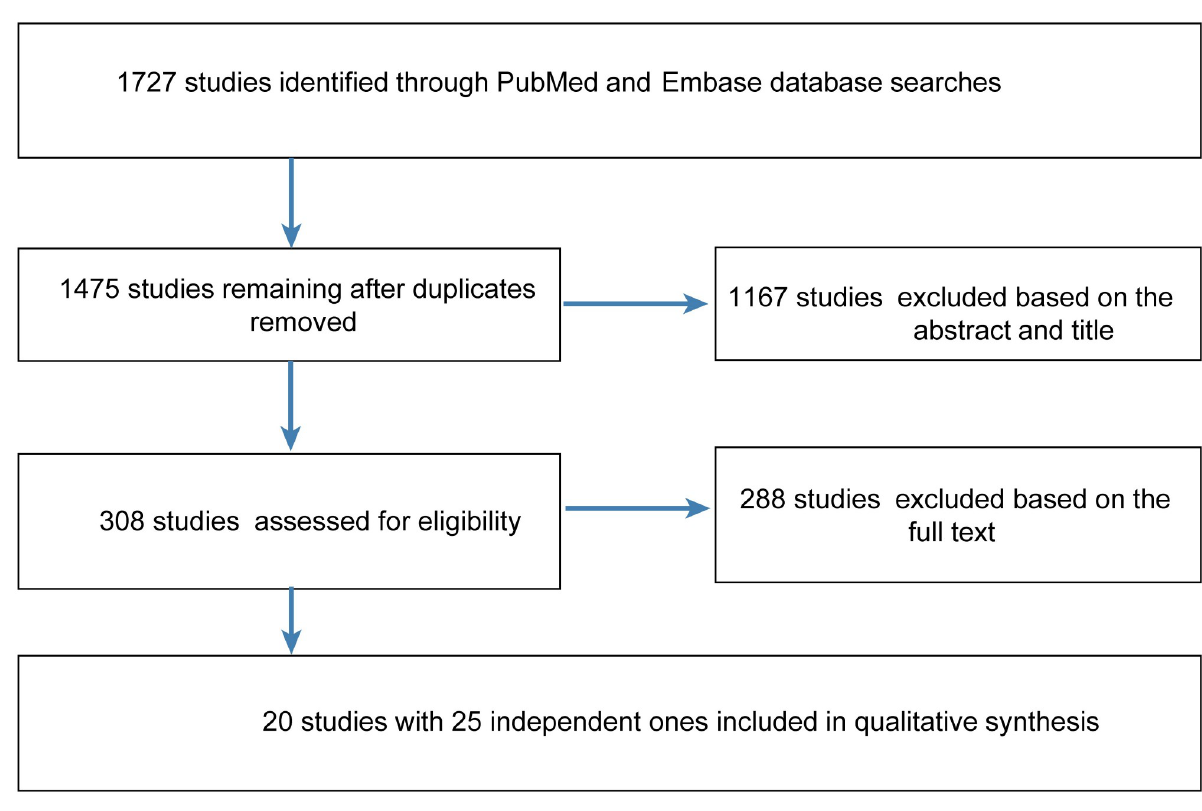
Fig 1. Flow diagram of the steps for study